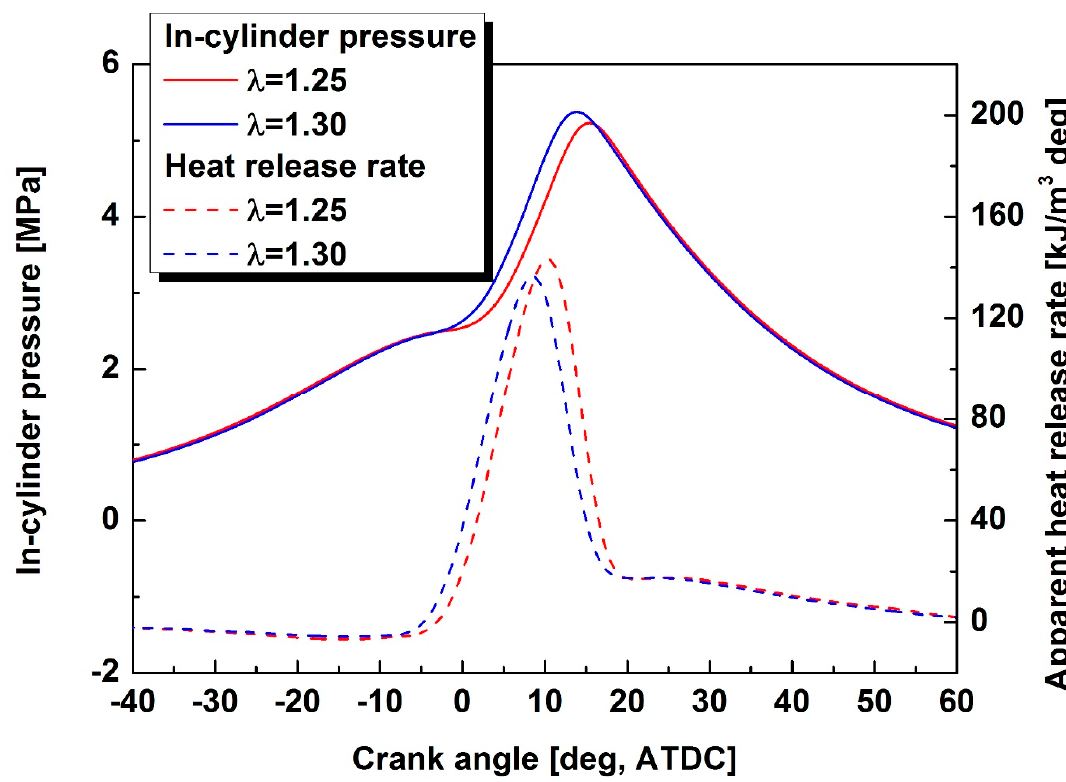
Figure 4. In-cylinder pressure and apparent heat release rate traces with maximum brake torque (MBT) spark advance time at excess air ratios of 1.25 and 1.30.